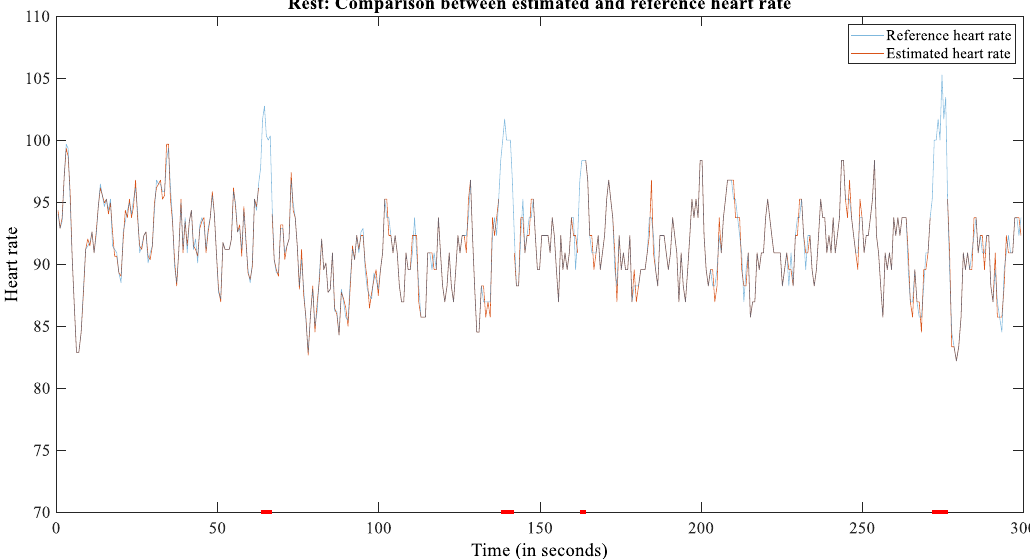
Figure 4. Distribution of the SNR for the different scenarios.